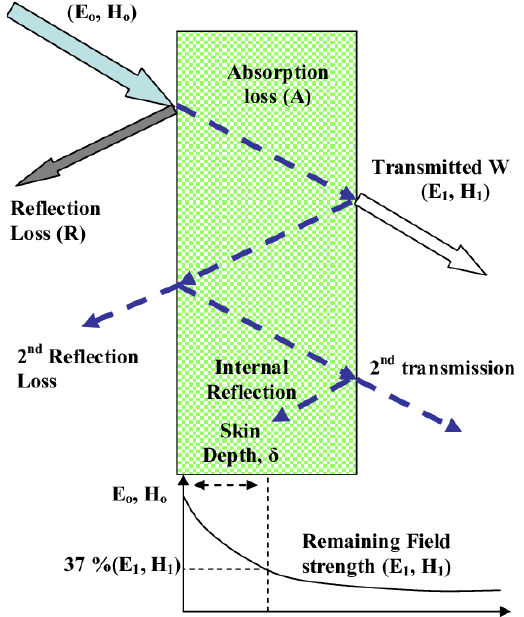
Figure 1. Interaction of EM waves with matter [28].